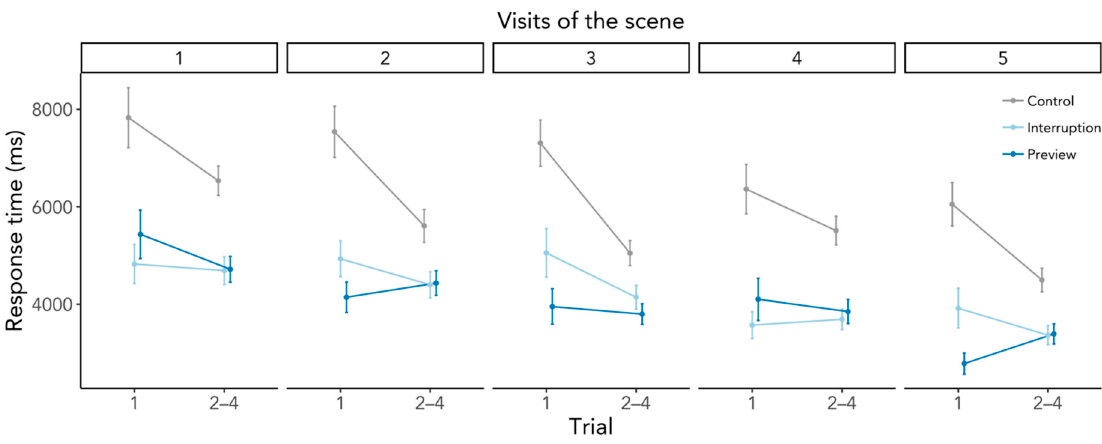
Figure A1. Response times for the first and the subsequent trials as a function of scene revisits. Error bars depict within-